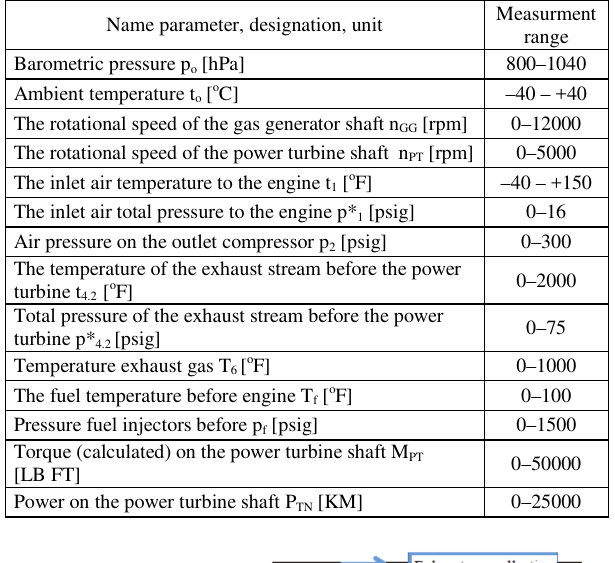
Table. 1. Operating parameters LM 2500 engine